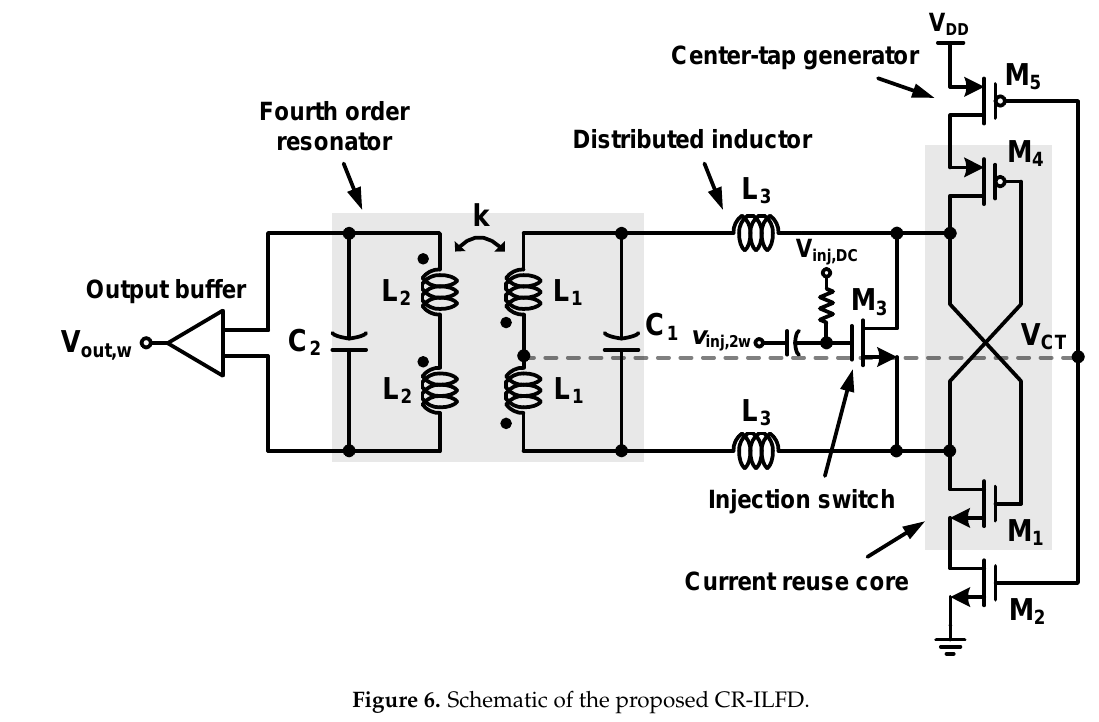
( b ) Figure 5. ( a ) Simulated magnitude plot and ( b ) phase plot of second-order resonator-based ILFD and fourth-order resonator-based ILFD.